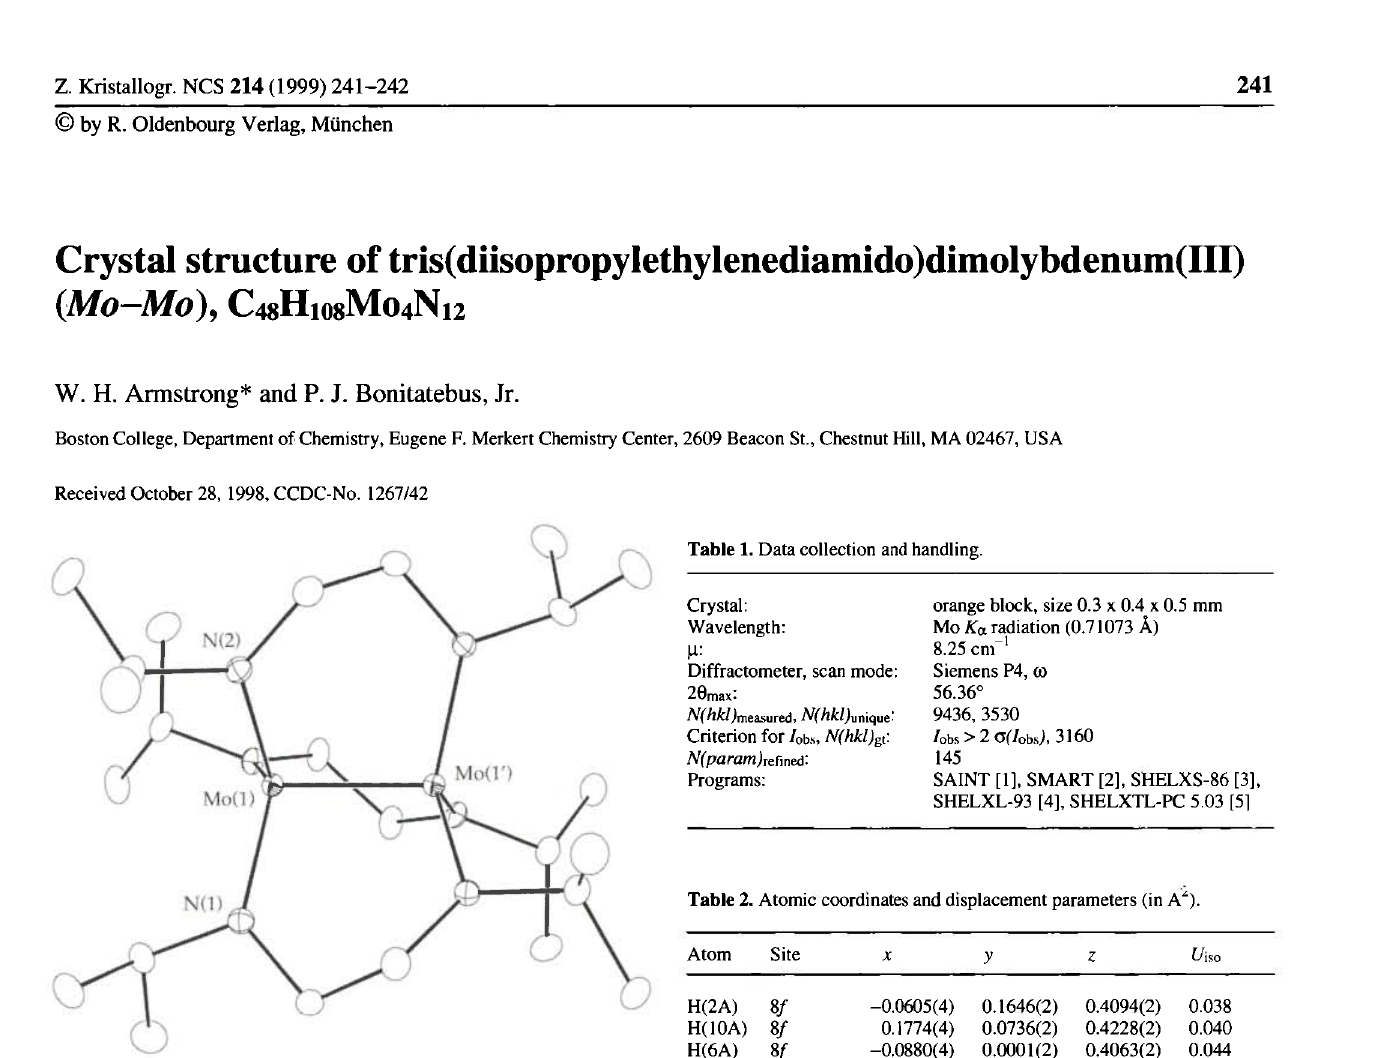
Table 2. Atomic coordinates and displacement parameters (in A